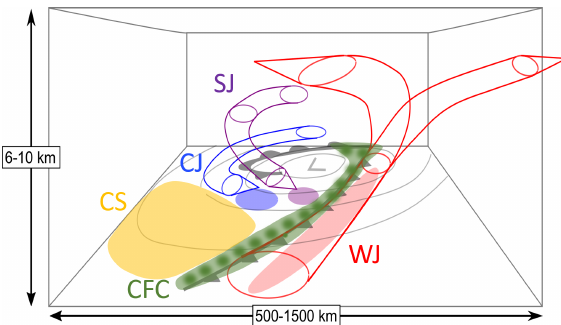
Figure 1. Conceptual model of the 3D structure of a SKC showing the WJ (red), CJ (blue) and SJ (magenta). In each case, the region of strong surface winds is indicated by an ellipse. The figure and caption have been adapted from (Clark and Gray, 2018; their Fig. 7) to include the CFC (green) and CS